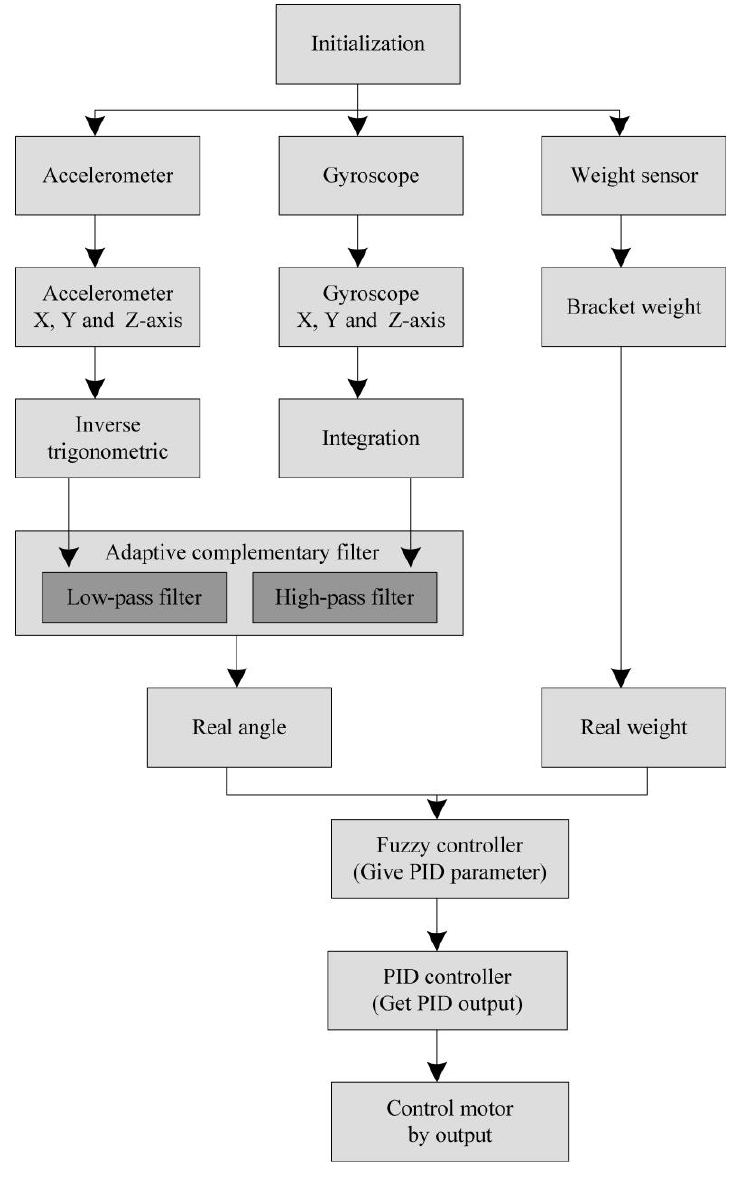
Figure 20. System workflow.